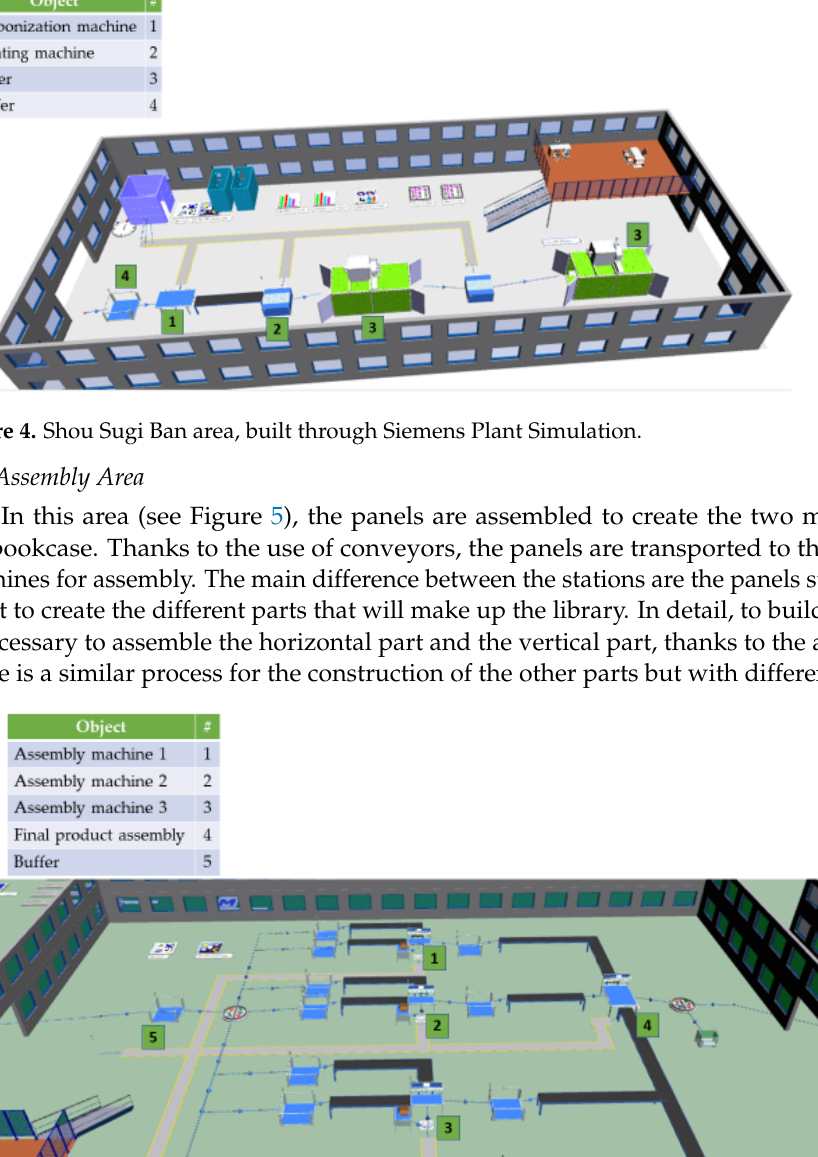
Figure 5. Assembly Area, built through Siemens Plant Simulation.